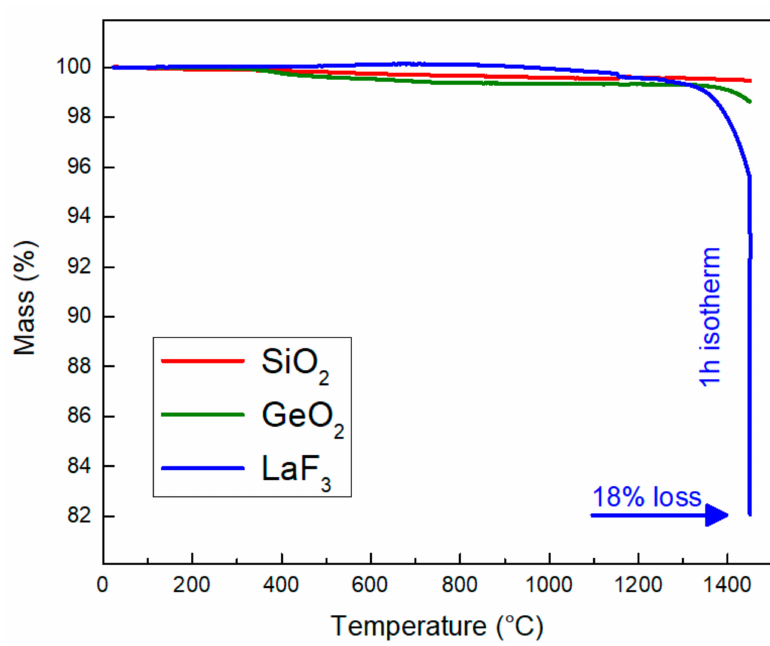
Figure 2. TGA curves of the different starting